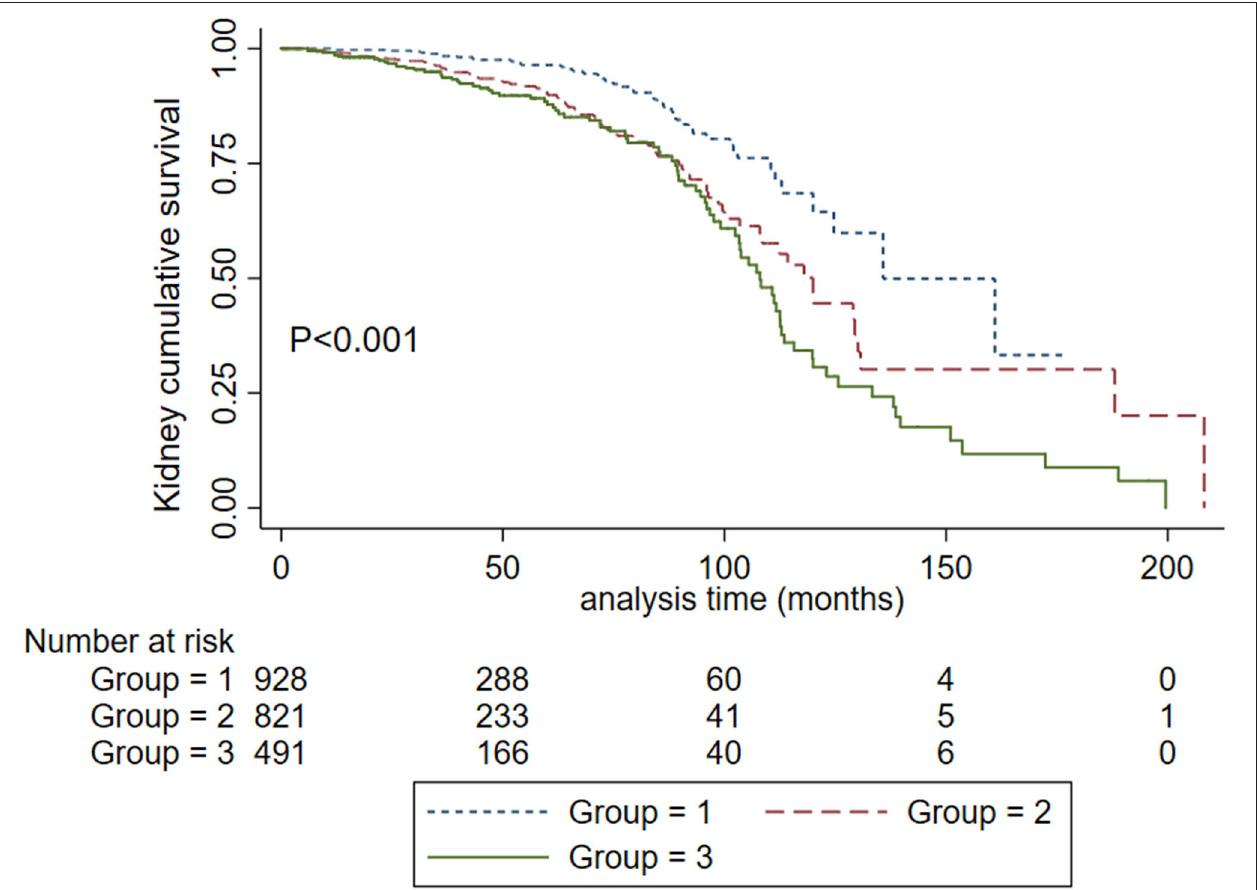
FIGURE 2 | Kaplan-Meier renal survival curves in IgA nephropathy patients according to SBP levels. Group 1. Systolic blood pressure < 120mm Hg. Group 2, systolic blood pressure < 140mm Hg and ≥ 120mm Hg. Group 3. Systolic blood pressure ≥ 140mm Hg.